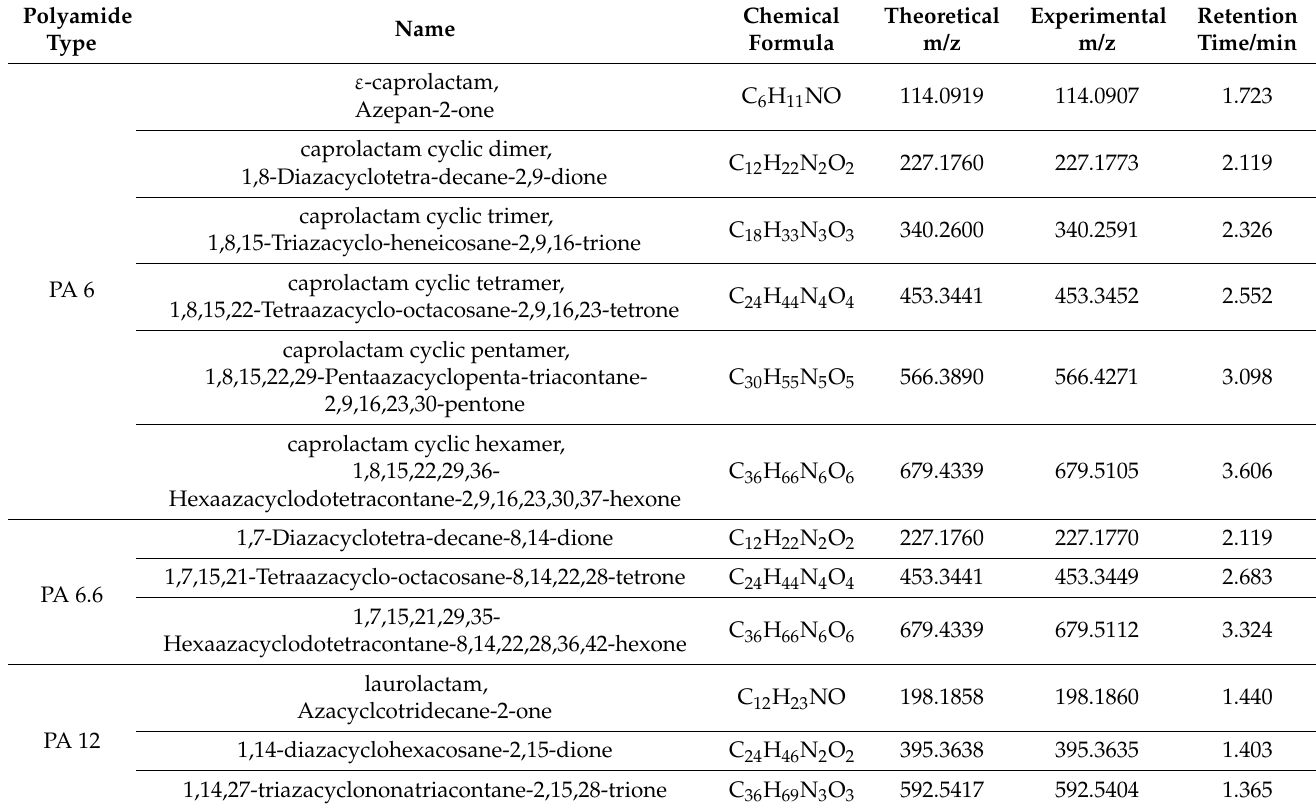
Table 1. Summary of identified marker compounds for the three polyamide